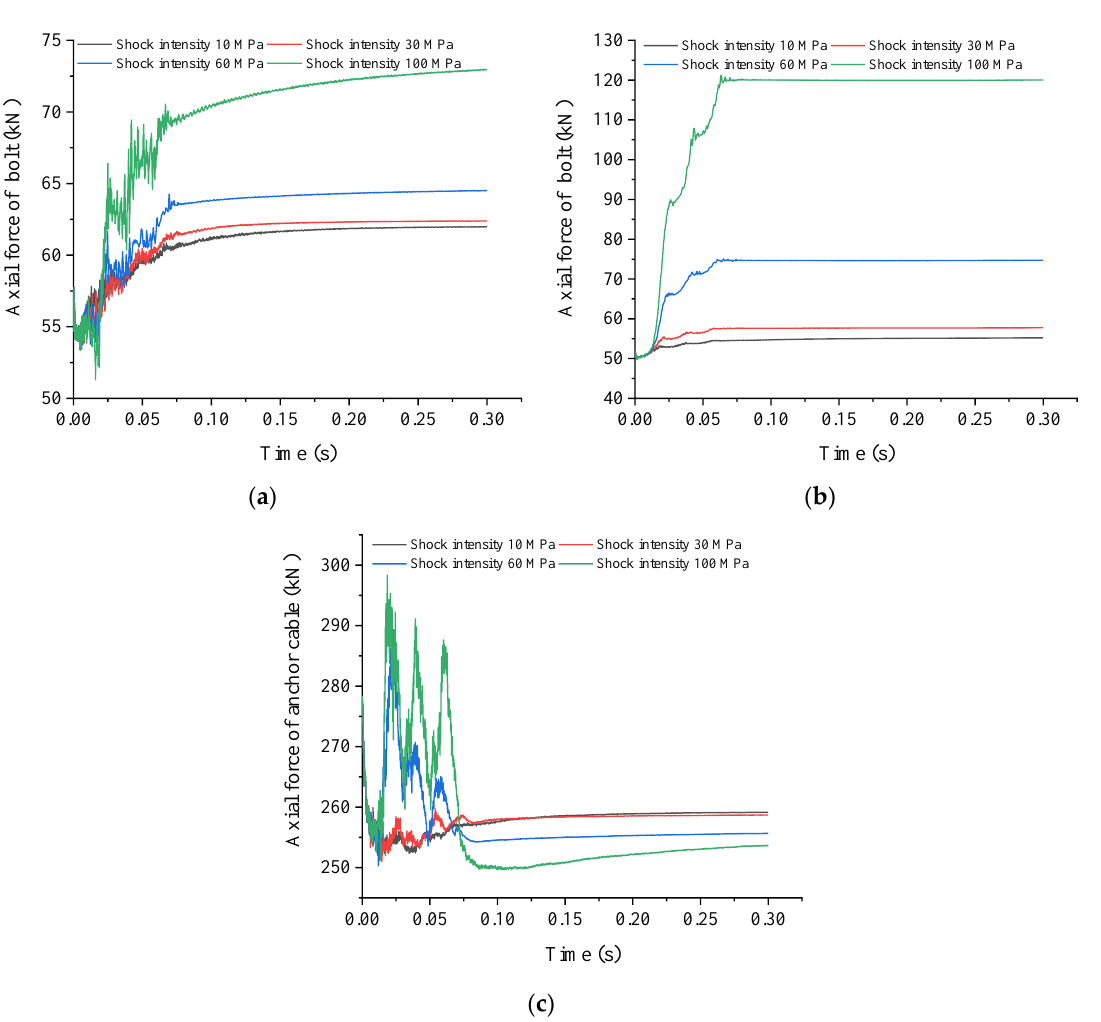
Figure 10. Axial force–time curve of anchor cables (bolts) for different shock intensities. ( a ) 2.5 m bolt of the roadway roof; ( b ) 2.5 m bolt of the roadway side; ( c ) 7.1 m anchor cable of the roadway roof.